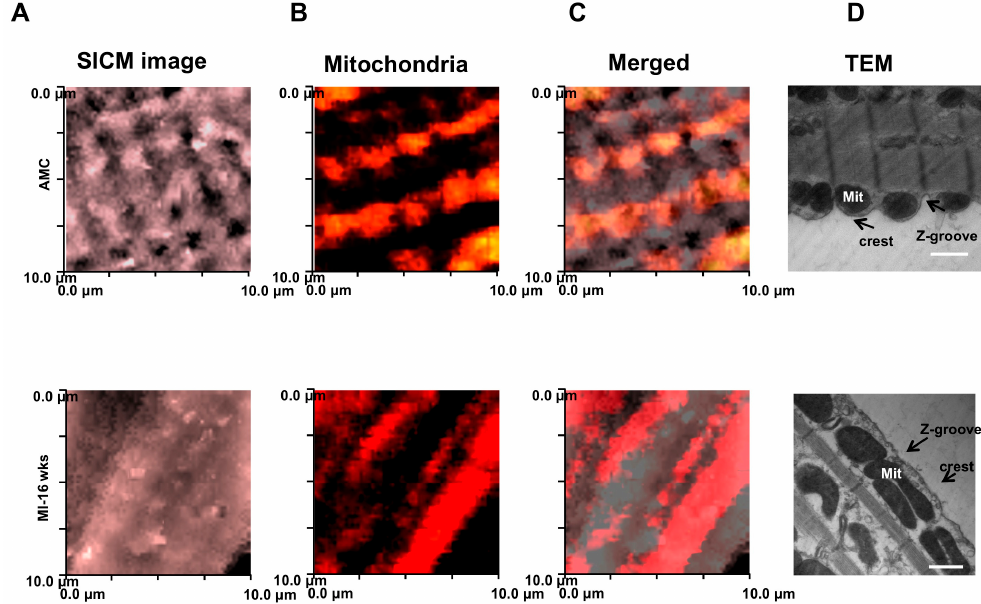
Figure 4. Surface scanning ion conductance microscopy analysis of mitochondrial displacement. ( A ) SICM images of 10 µm × 10 µm cardiomyocyte regions of AMC (top) and MI (bottom) cells; ( B ) Surface confocal images (obtained by SSICM) of the labelled TMRM active mitochondria in ( A ); ( C ) Merged images for SICM topography TMRM-labelled mitochondria; ( D ) Mitochondrial displacement observed by TEM. Scale bar: 500 nm Modified from [6] with permission.